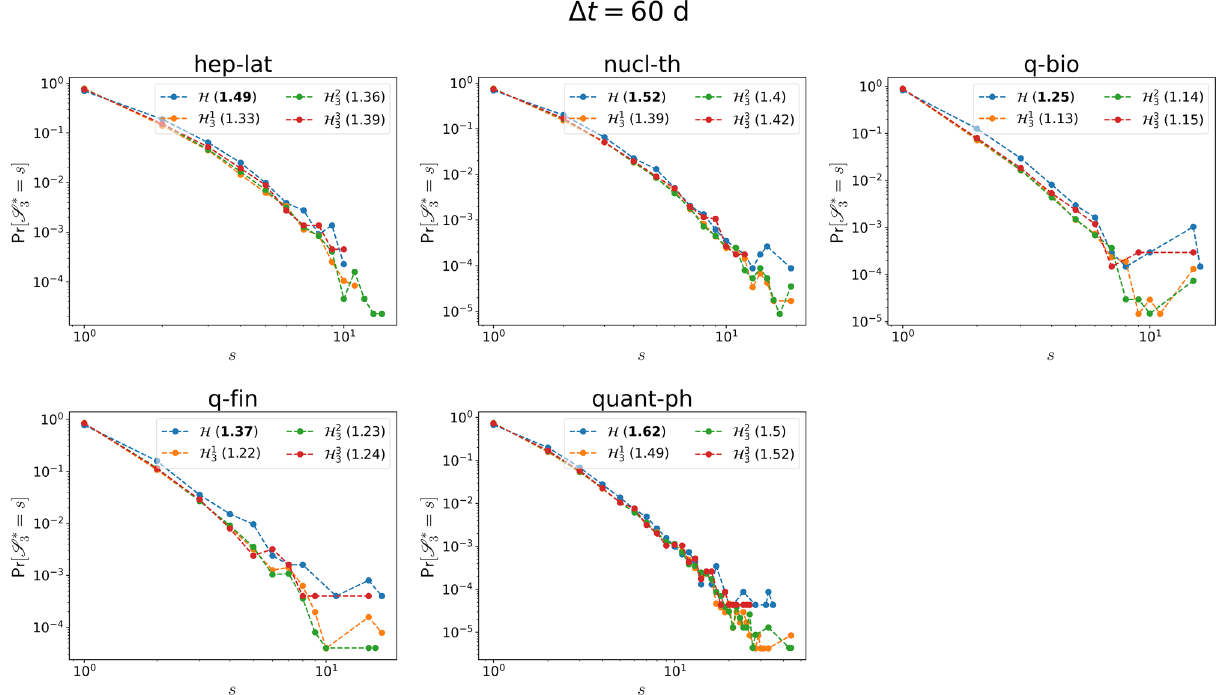
Figure 13. Probability distribution Pr [ S ∗ 3 = s ] of the size S ∗ 3 of trains (obtained from the activity series of egonetworks centered at each order 3 hyperlink), where a center link is activated at least once, in each collaboration network H (blue) and its three randomized reference models H 1 3 (yellow), H 2 3 (green) and H 3 3 (red). To identify the trains, we consider (cid:31) t = 60 s . For each network, the average size of the trains is reported. The maximum average size among network H , H 1 3 , H 2 3 and H 3 3 is in bold. The horizontal and vertical axes are presented in logarithmic